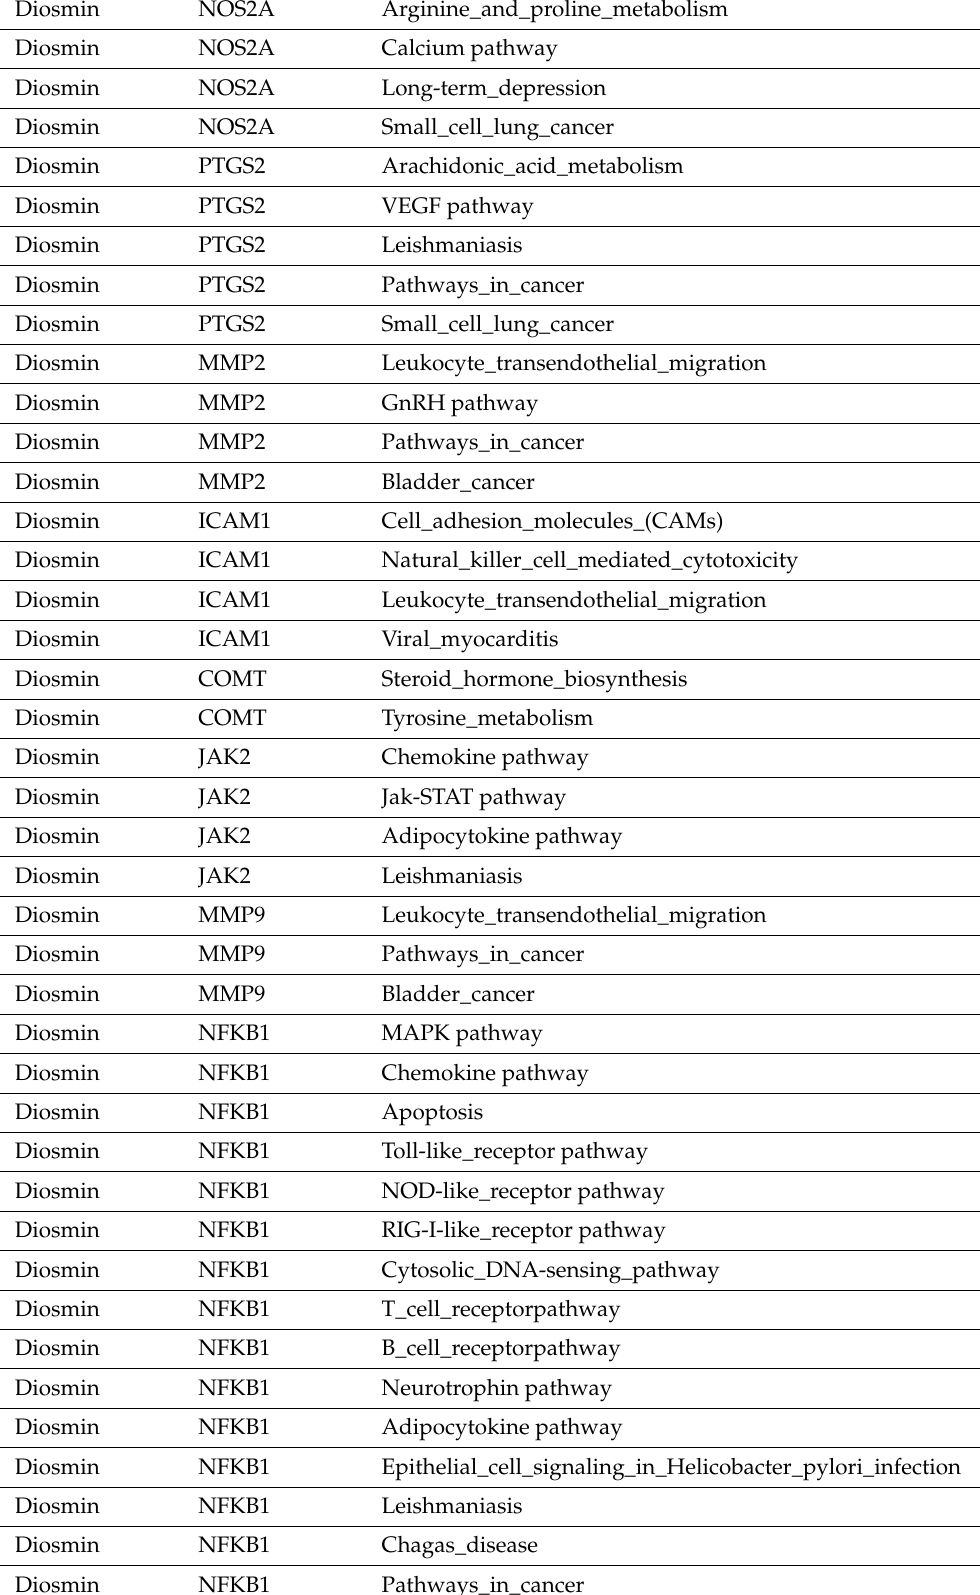
Table 1. Diosmin and its potential interactors followed by their